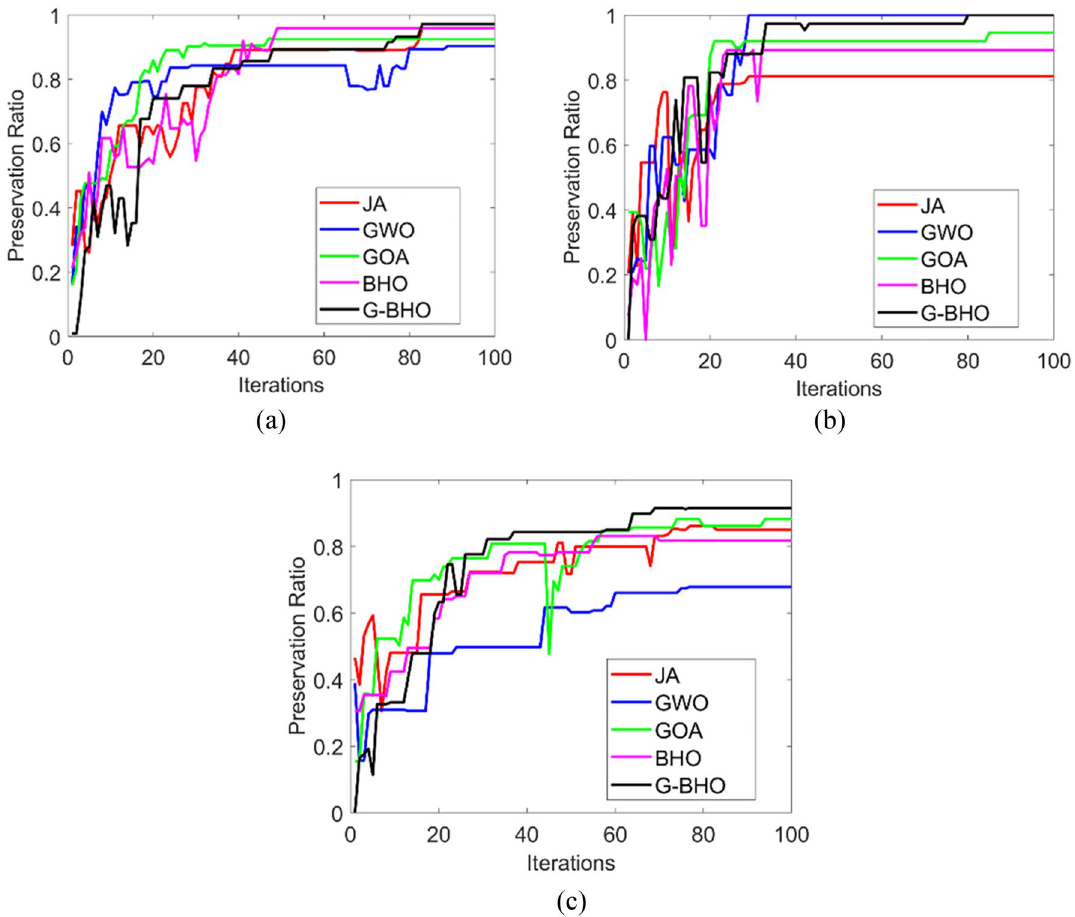
Figure 8. Analysis on the privacy preservation ratio of the designed intelligent privacy preservation model using ( a ) Test case 1, ( b ) Test case 2, ( c ) Test case